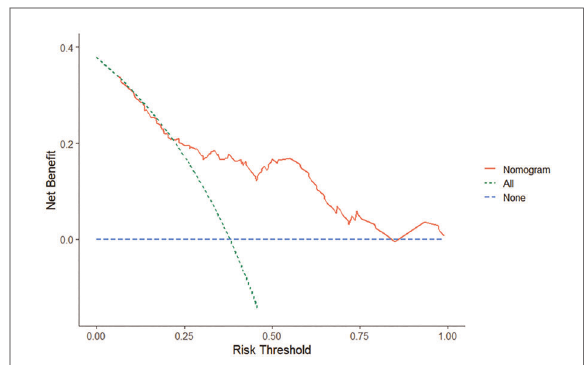
FIGURE 4 Decision curve analysis of the nomogram. The red solid line represents the nomogram. The decision curve indicates that when the threshold probability of CPSP is between 25% and 100%, the application of this nomogram will add a net bene fi t compared to the treat-all or treat-none